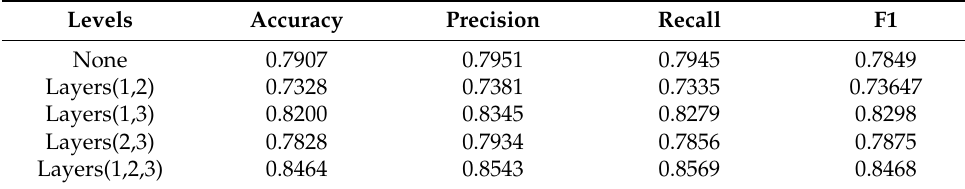
Table 5. Comparison of different Multi-level structures in RA_XZ dataset.